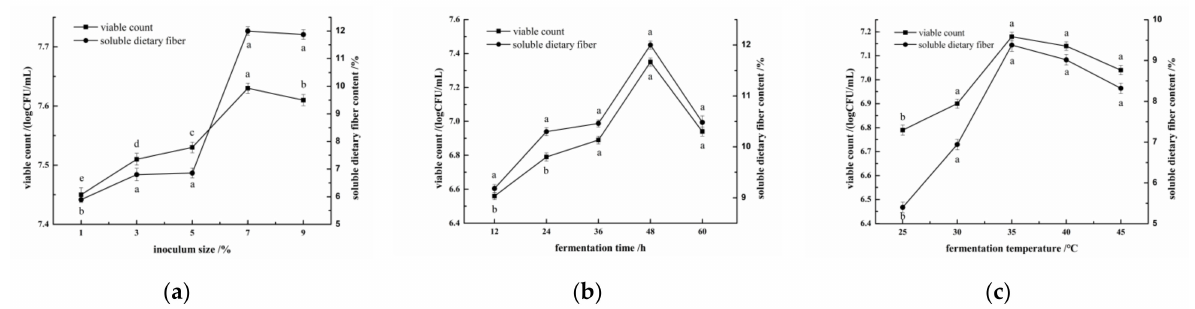
Figure 1. Effect of ( a ) inoculum size, ( b ) fermentation time, and ( c ) fermentation temperature on viable count and content of SDF. The letters a, b, c, and d in the figure represent significant differences between different letters. ( p <